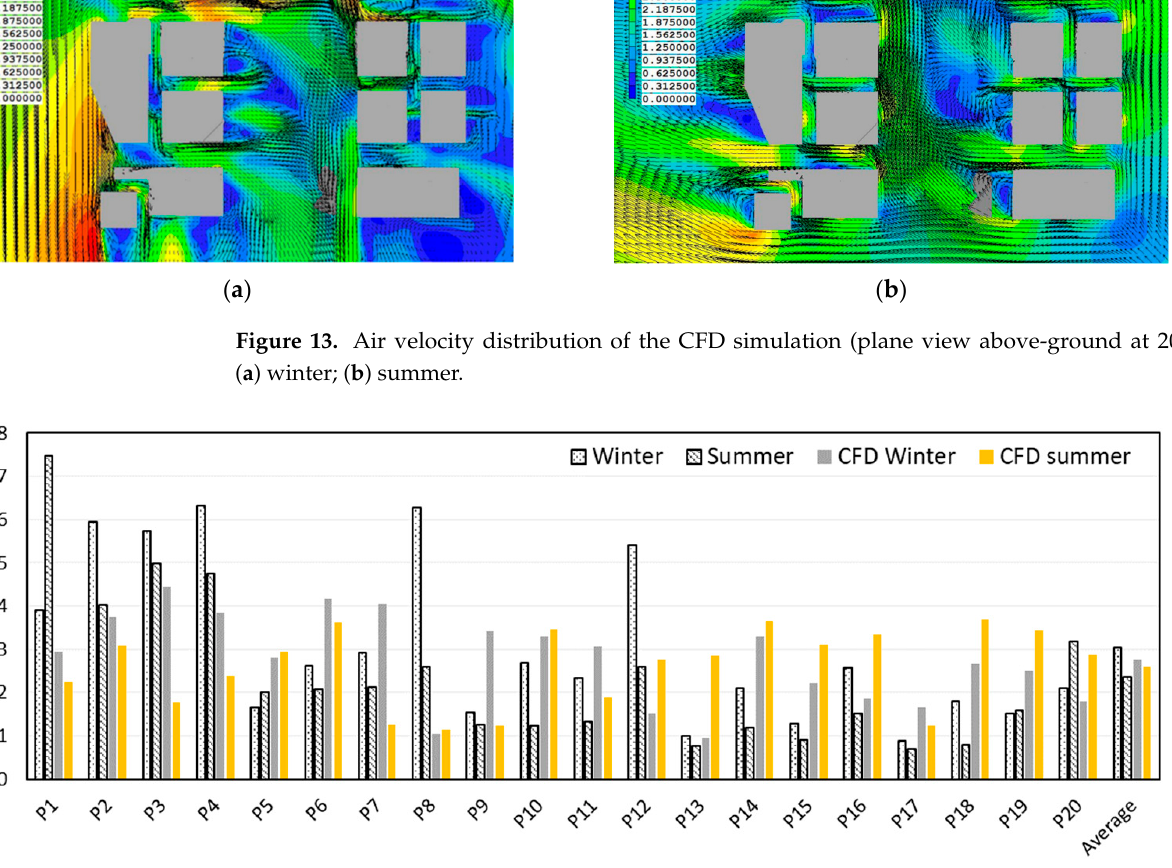
Figure 13. Air velocity distribution of the CFD simulation (plane view above-ground at 20 m). ( a ) winter; ( b ) summer.